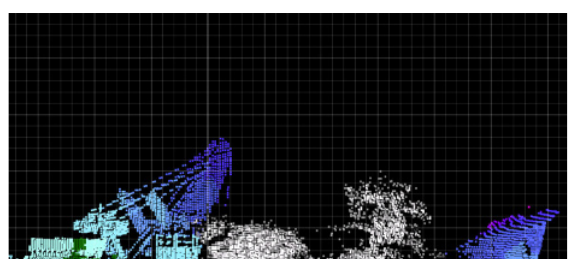
Figure 5: Imaging with a conventional lidar